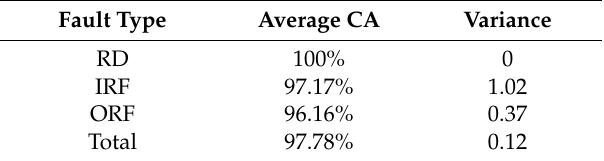
Table 3. The testing accuracy for different bearing conditions using the SVM ensemble classifier.